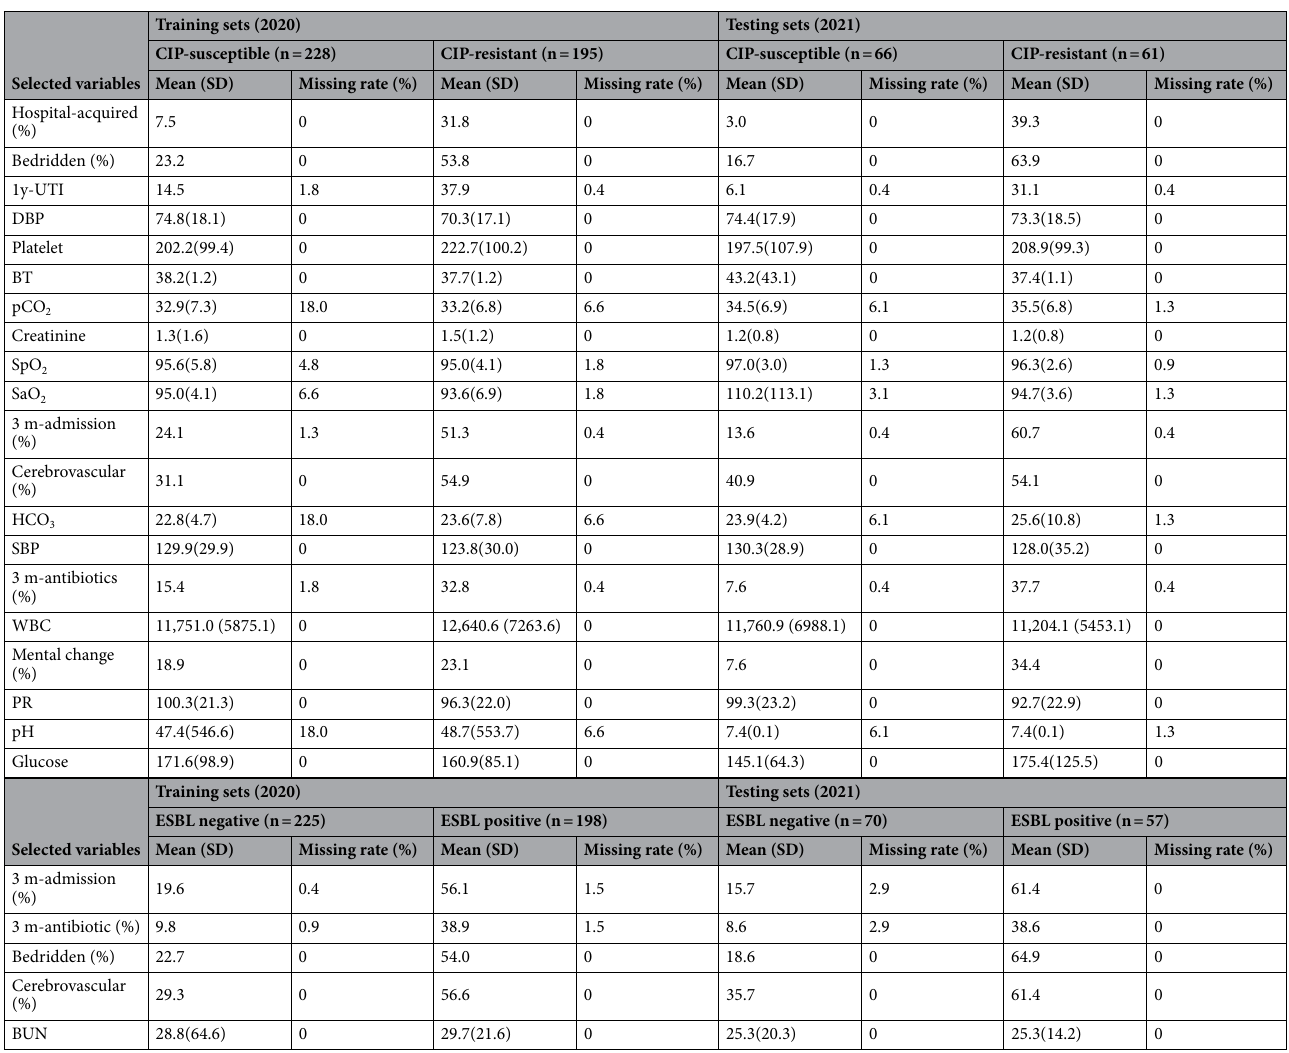
Table 2. Selected variables during customization each for predicting ciprofloxacin (CIP) resistance and ESBL positivity with data distribution. SD, standard deviation; 1y-UTI, UTI within a year; DBP, diastolic blood pressure; BT, body temperature; SpO2, peripheral oxygen saturation; SaO2, arterial oxygen saturation; 3 m-admission, hospitalization within 3 months; SBP, systolic blood pressure; 3 m-antibiotics, antibiotics use within 3 months; WBC, leukocyte count; PR, pulse